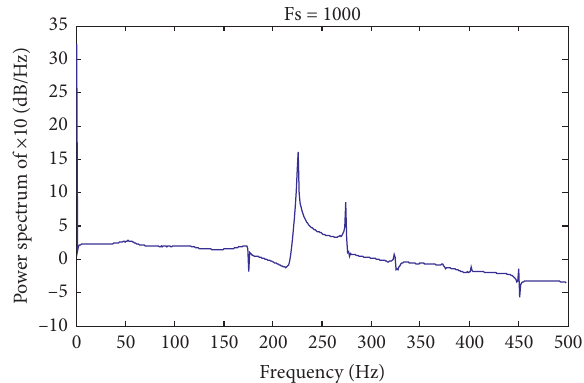
Figure 46: Power spectrum of x